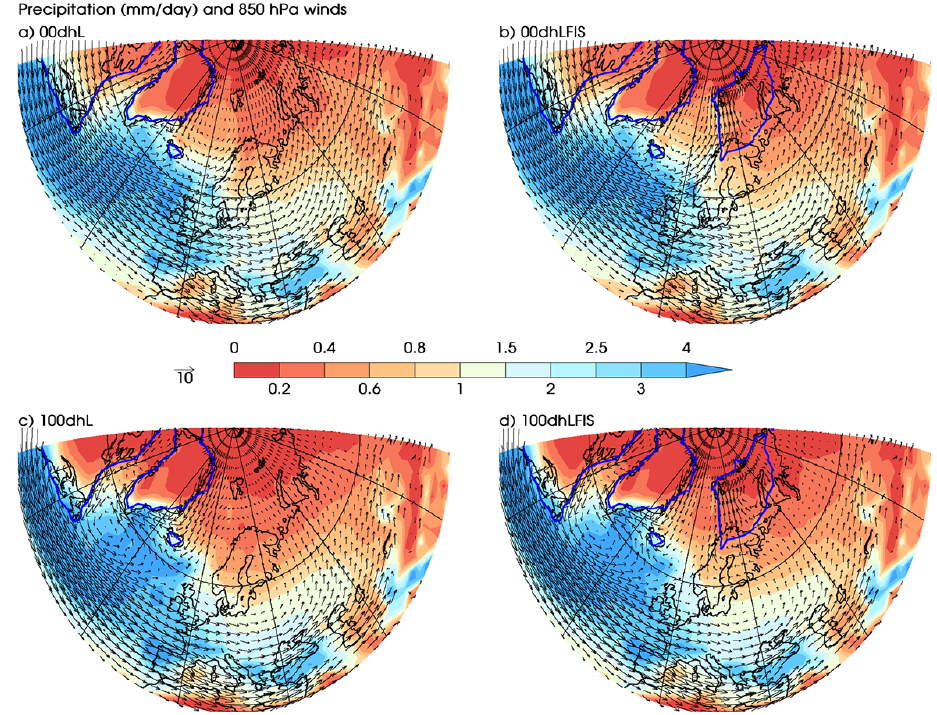
Figure 18. Same as Fig. 14 for the precipitation (mmday − 1 ) and 850hPa horizontal winds in